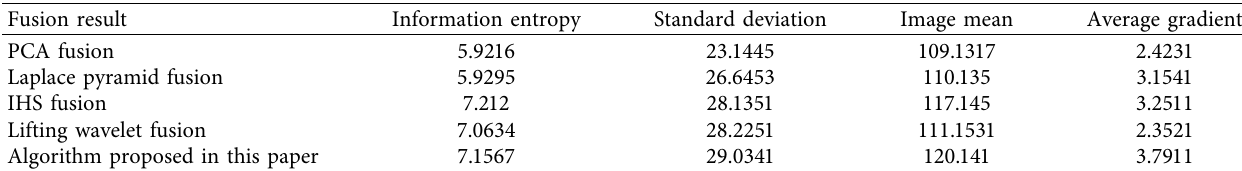
Table 11: Analysis of comparison results of all fusion